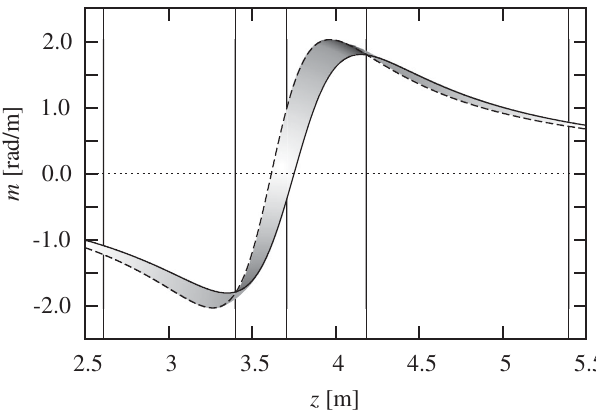
FIG. 7. Development of the slopes of the phase space ellipses for the high perveance slice (solid line) and the low perveance slice (broken line). The plot corresponds to Fig. 6. The solutions for slices with intermediate perveance are indicated by the gray shaded band. Vertical lines at z ¼ 2 . 6 , 3.4, 3.7, 4.2, and 5.4 m indicate the positions referred to in Fig. 8.